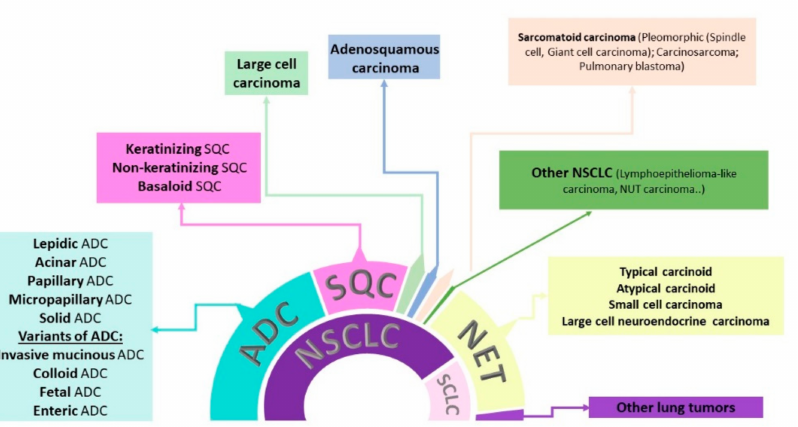
Figure 1. Classification of lung tumors based on resection specimens. The inner circle represents the traditional classification of lung tumors into non-small cell lung cancer (NSCLC) and small cell lung cancer (SCLC). The outer circle represents the WHO 2021 classification of lung tumors, in which SCLC is grouped with other types in the category of neuroendocrine tumors. ADC—adenocarcinoma; SQC—squamous cell carcinoma; NET—neuroendocrine